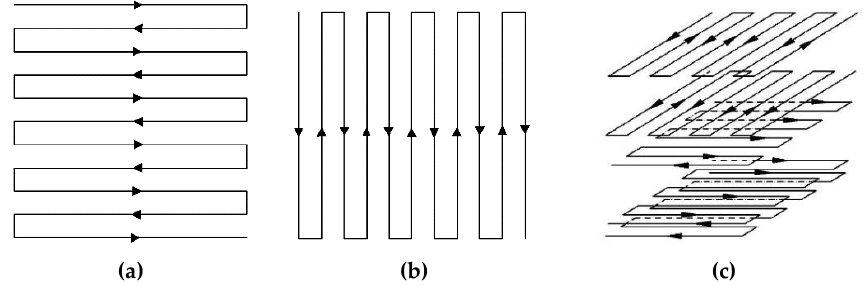
Figure 1. Three different zigzag strategies. ( a ) x-axis scanning strategy ( b ) y-axis scanning strategy, ( c ) multi-direction scanning strategy.